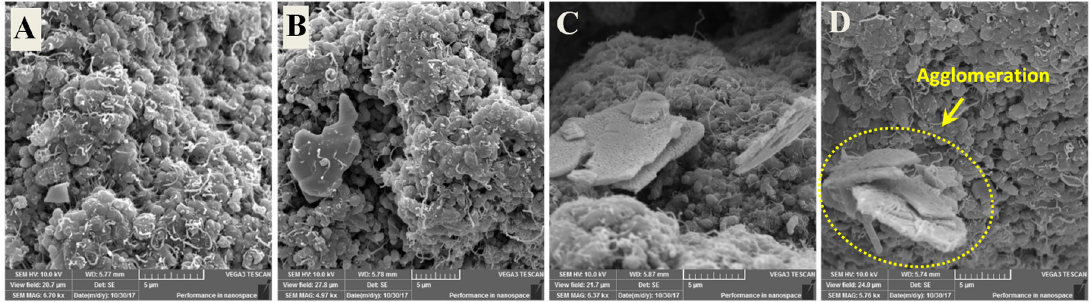
Figure 7. SEM images showing the dispersion of ( A ) 0.5 wt.%, ( B ) 1.5 wt.%, ( C ) 3 wt.% and ( D ) 5 wt.% of hydroxyapatite (HA) in UHMWPE/1.5 wt.% CNT’s matrix.